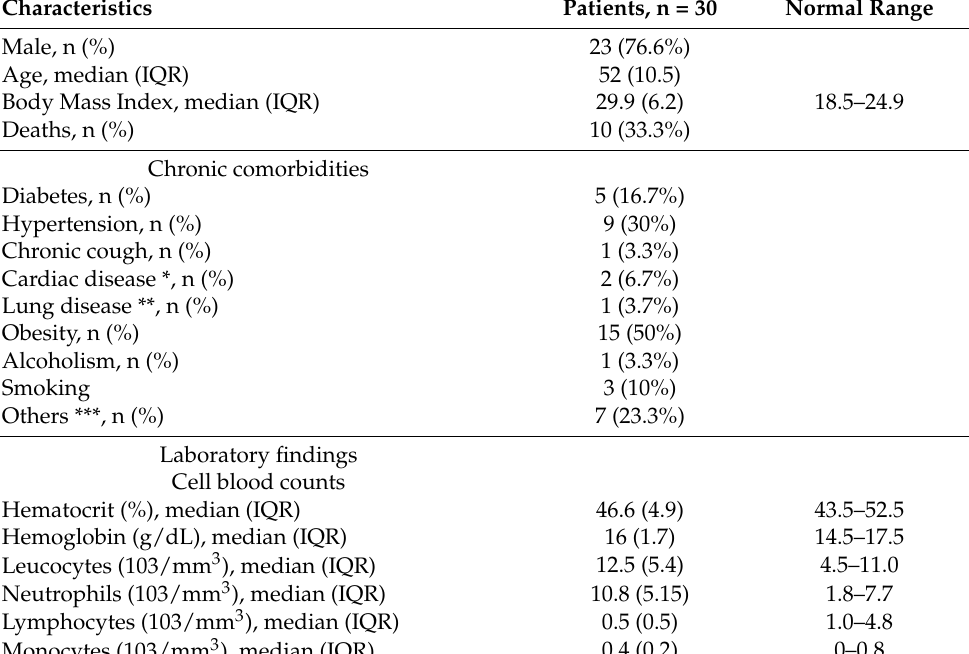
Table 1. Baseline characteristics of the studied